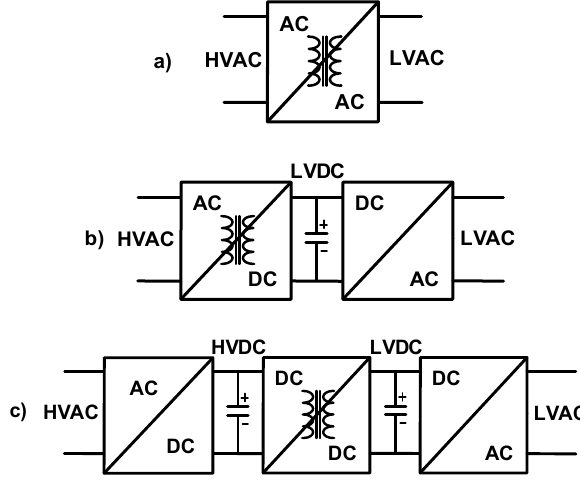
Figure 1. Solid state transformer (SST) topologies: ( a ) single stage, ( b ) two stages, and ( c ) three stages.